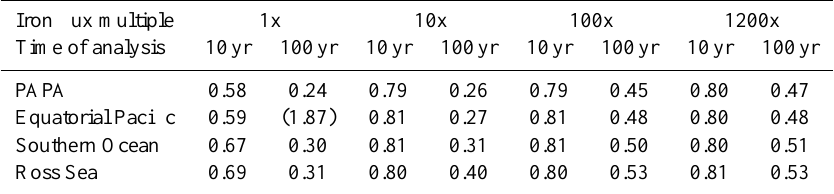
Table 6. Atmospheric reservoir effect. The table shows the ratio of a model with an atmospheric reservoir to the same simulation without a reservoir. The Equatorial Pacific 1x result is not trustworthy because the cumulative uptake is near 0 at 100